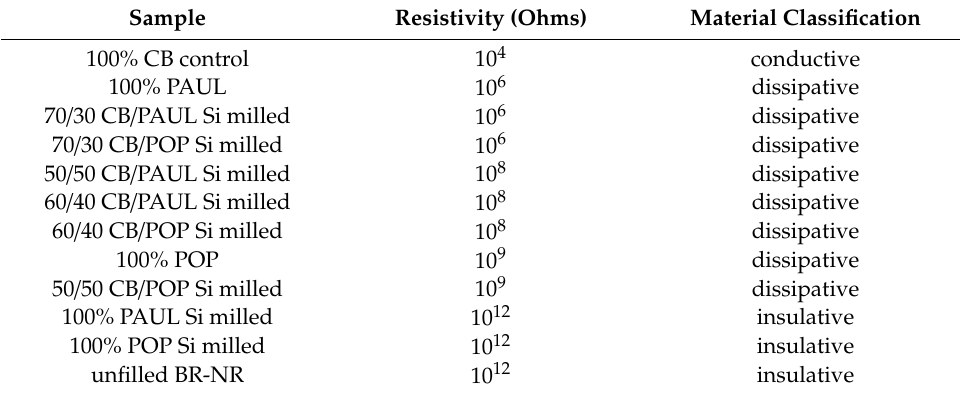
Table 3. Resistivity of Rubber Composite